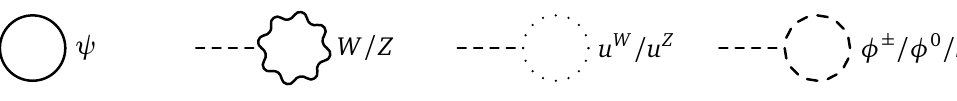
Figure 1: One loop diagrams contributing to the Tadpole. The photon and gluons and their corresponding ghosts do not contribute as they are massless the loop integrals are identically